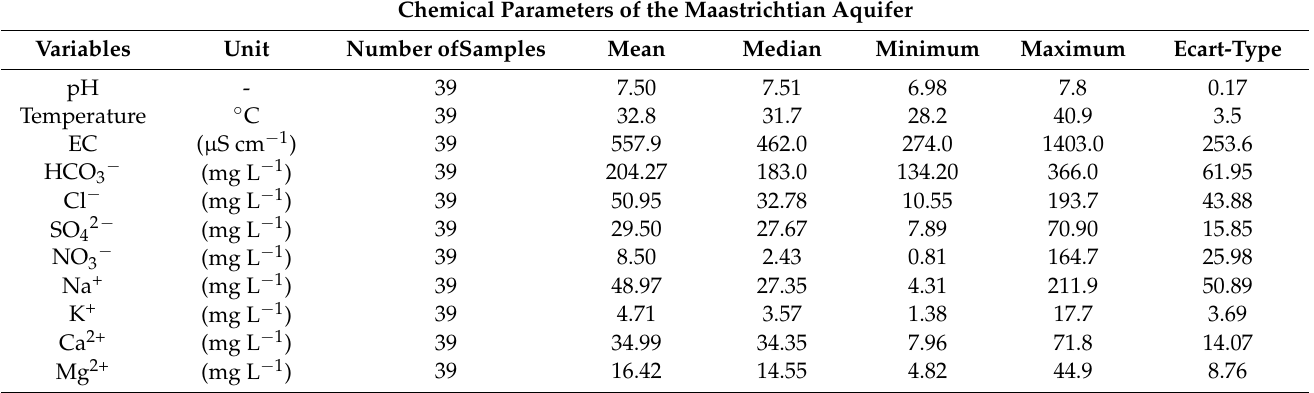
Table 1. Summary statistics of the Maastrichtian groundwater quality parameters sampled in June